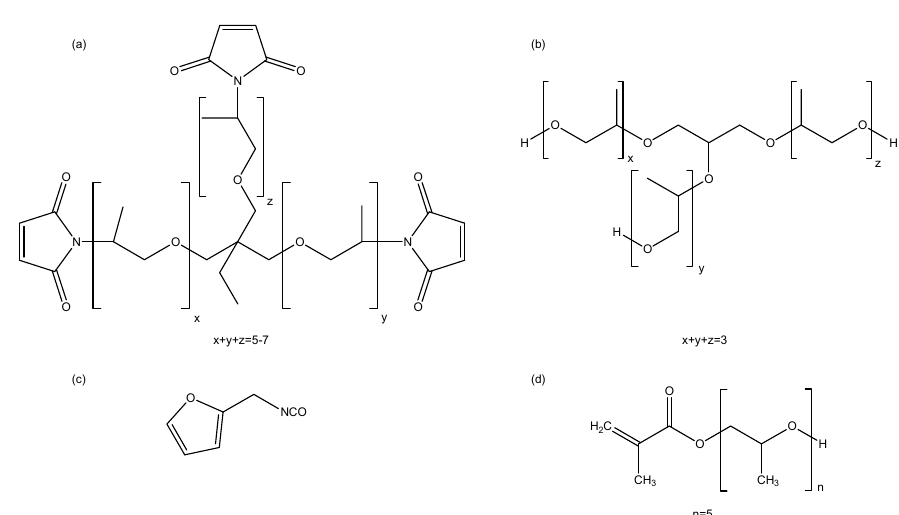
Figure 2. Chemical structures of the starting reagents: ( a ) amorphous trismaleimide 3M, ( b ) glycerol ‐ based polyol Daltolac R630, ( c ) furfuryl isocyanate, ( d ) poly(propylene glycol) methacrylate PPG375 ‐ MA.